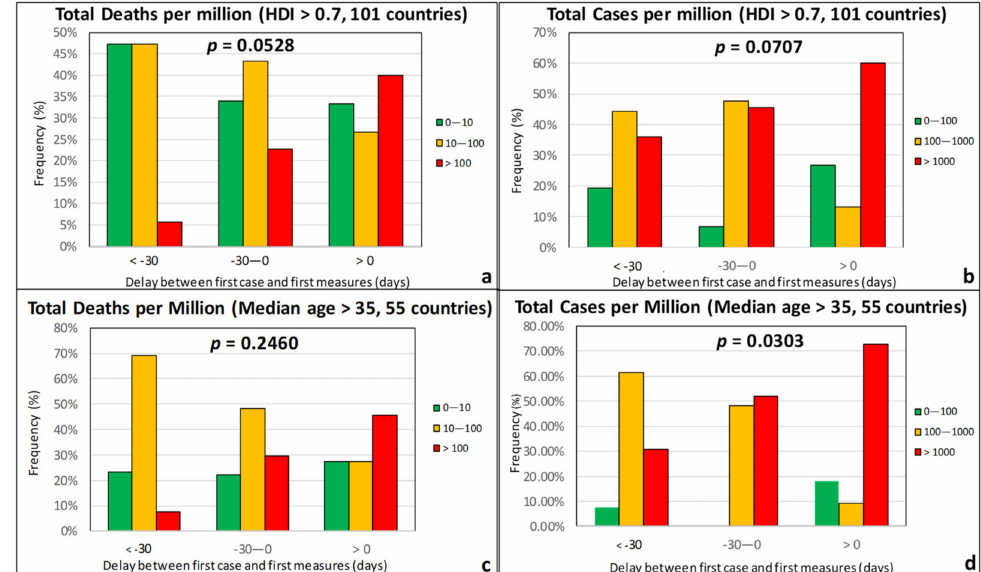
Figure 14. Frequency of total deaths per million (green: low, 0–10; orange: moderate, 10–100; red: high, > 100) and total cases per million (green: low, 0–100; orange: moderate, 100–1000; red: high, > 1000) as a function of the time di ff erence between first case and first measures for countries with an HDI over 0.7 ( a , b ) and a median age over 35 years ( c , d ).